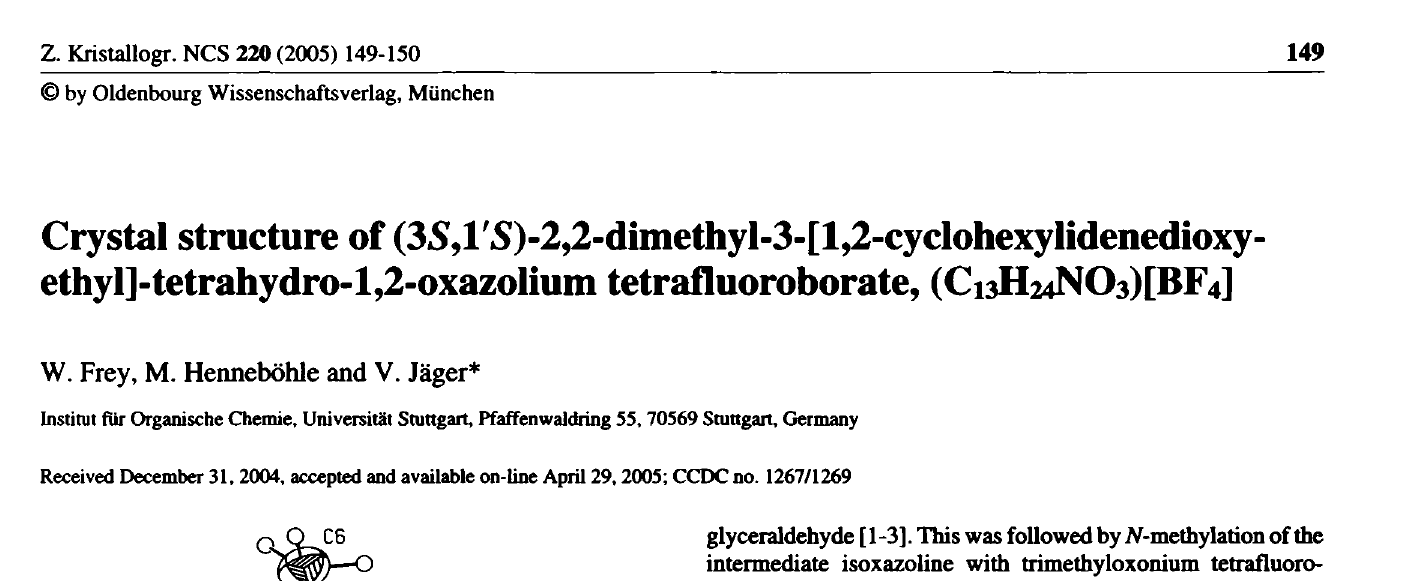
Table 1. Data collection and handling.